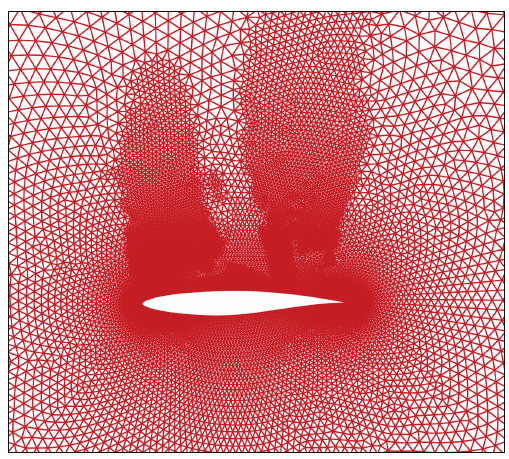
Figure 3: Adapted RAE2822 airfoil mesh.